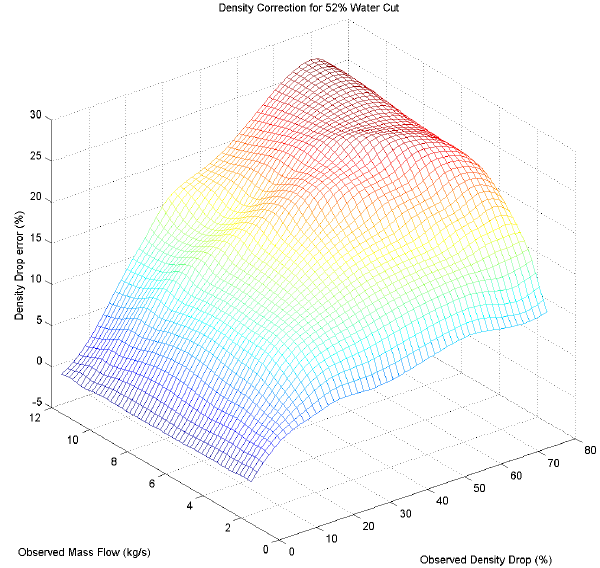
Figure 4. Density error induced by e ff ects of three-phase flow.